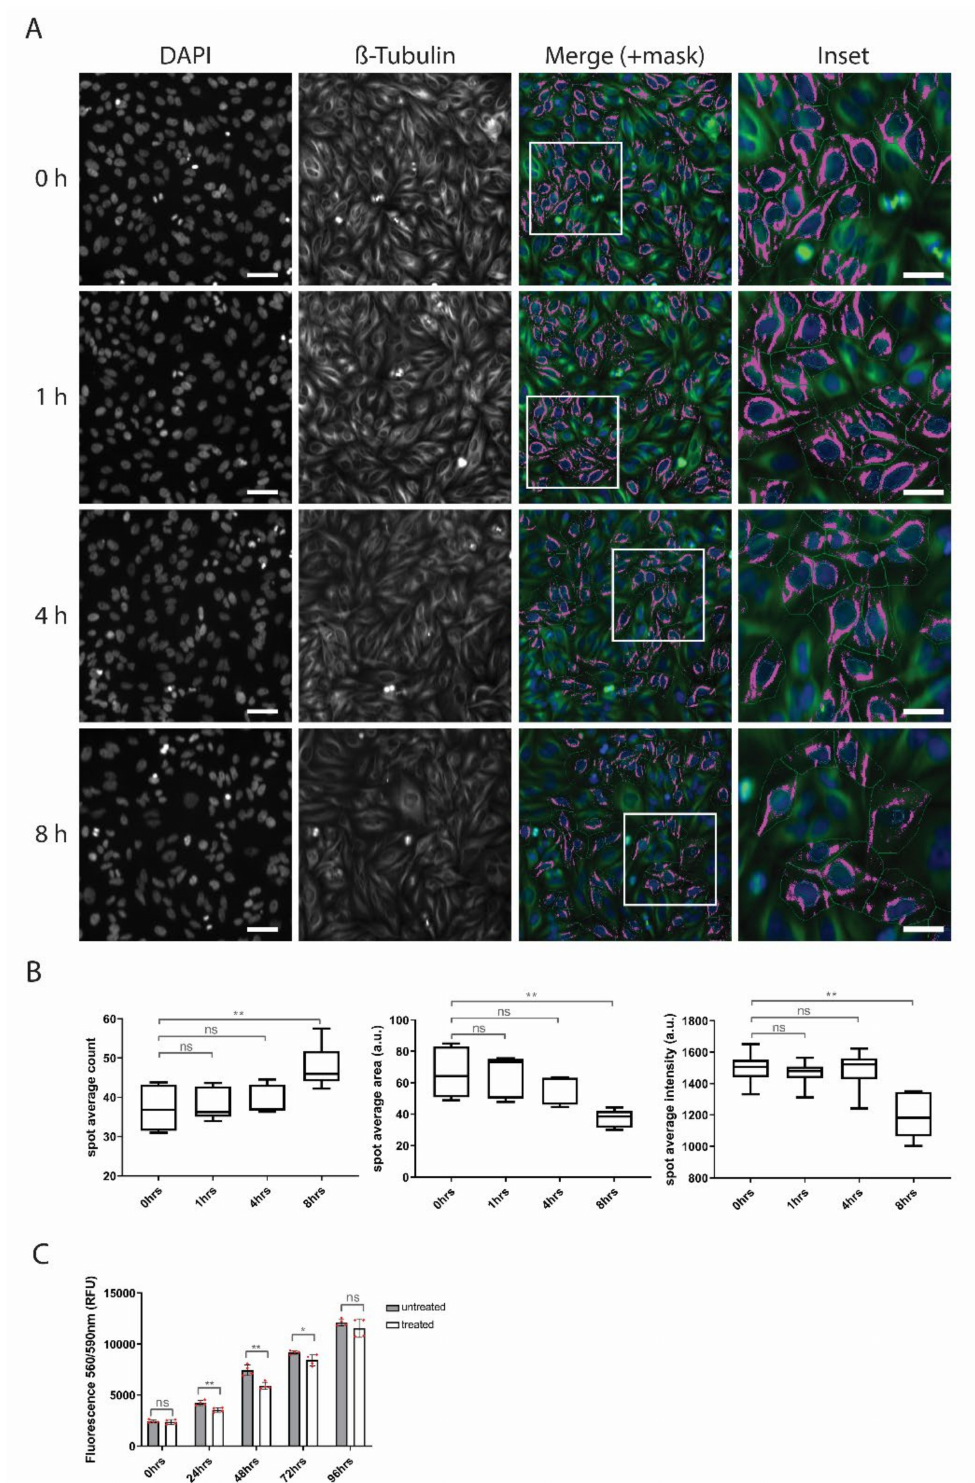
Figure 8. ( A ) Representative IF pictures of β -tubulin-stained cells with a mask used for quantification by high-content screening (HCS) platform. Scale bar is 20 µ m. Scale bar in the inset is 5 µ m. ( B ) Quantification of HCS of β -tubulin staining shows gradual decrease of spot intensity and area an increase in spot count. ( C ) CTB proliferation assay shows decreased proliferation rate upon penetratin treatment. Significance: * p < 0.05, ** p < 0.01, ns not